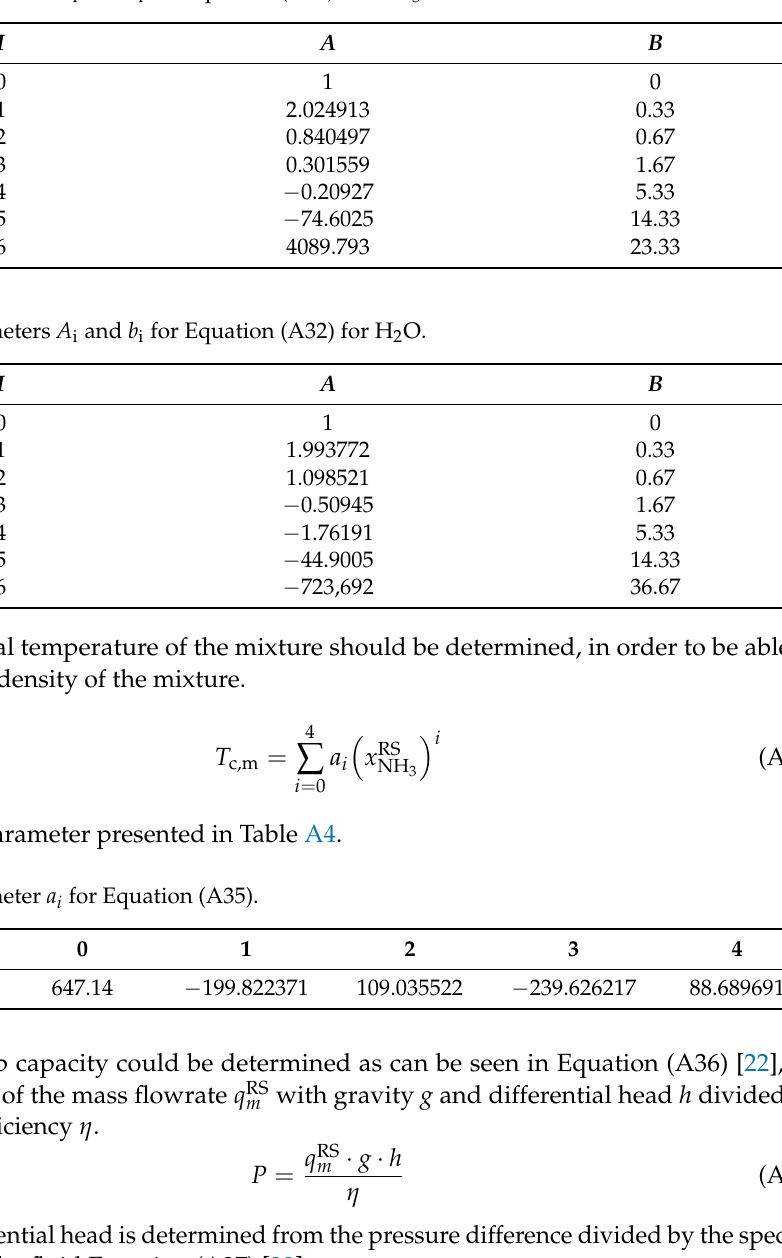
Table A2. Parameters A i and b i for Equation (A32) for NH 3 .